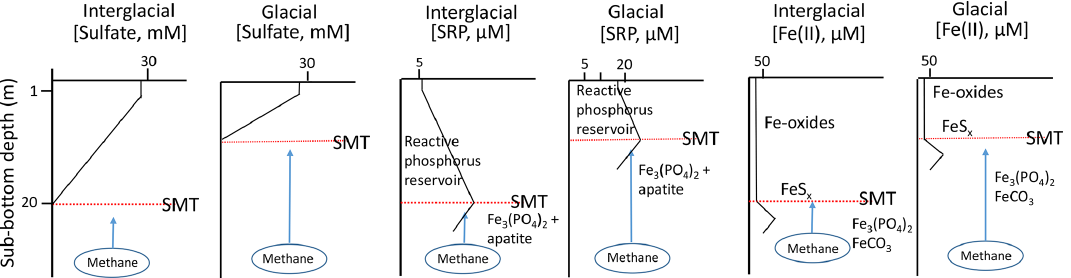
Figure 2. Pore-water profiles for relevant species (CH 4 / SO 4 / Fe ( II )/ H 2 S). Note that the SMT migrates vertically when forced by vari- able CH 4 fluxes. Given the added SRP flux generated by the vertically migrating SMT, the concentration of maximum buffering capacity of the sediment (or zero equilibrium phosphate concentration (EPC 0 ); see Sundby et al. (1992) for details, a concept first introduced by Froelich (1988)),will be rapidly exceeded and the pore-water SRP concentration gradient across the SWI will strengthen. If the flux of SRP from below is large enough, the buffering (or adsorption) capacity of the authigenic iron oxides may be overwhelmed, and the linear gradient could extend all the way to the